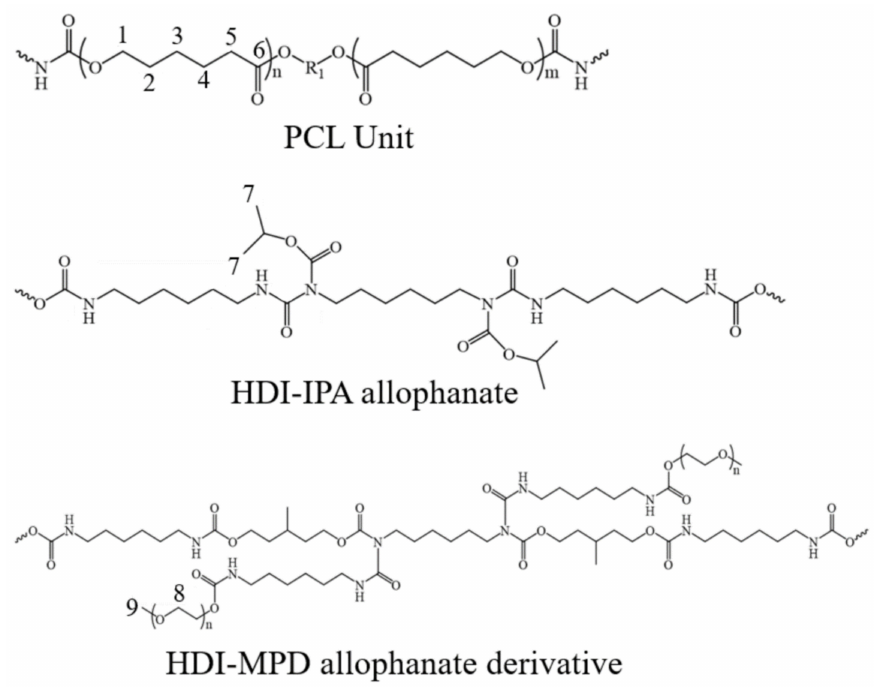
Figure 1. Structural units of biodegradable PU. The number of each carbon observed in the 13 C solid-state NMR spectra in this paper is